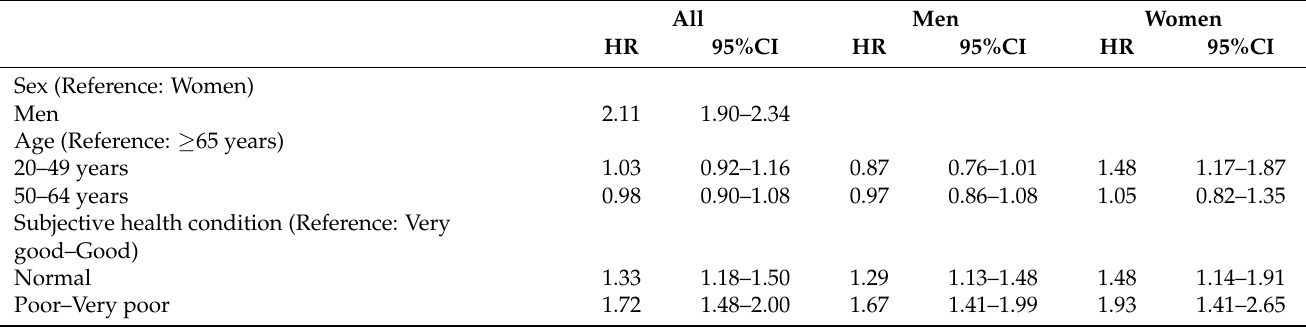
Table A2. Crude hazard ratios and 95% confidence intervals for the occurrence of problem drinking from FY 2012 to FY